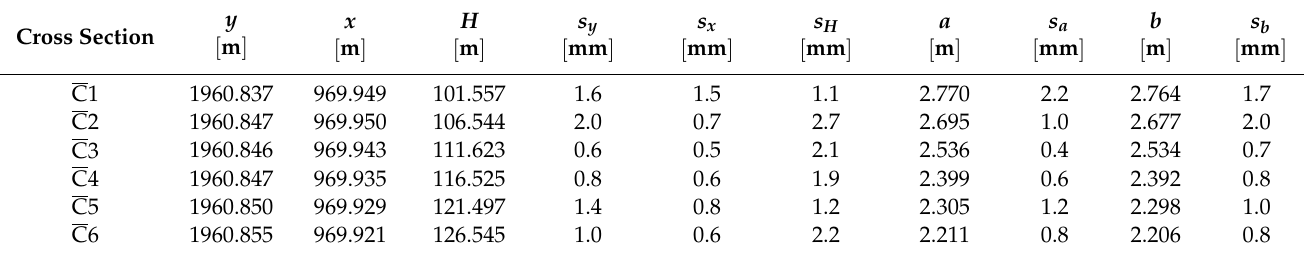
Table 4. Results of TS-based chimney elliptical cross-sectional